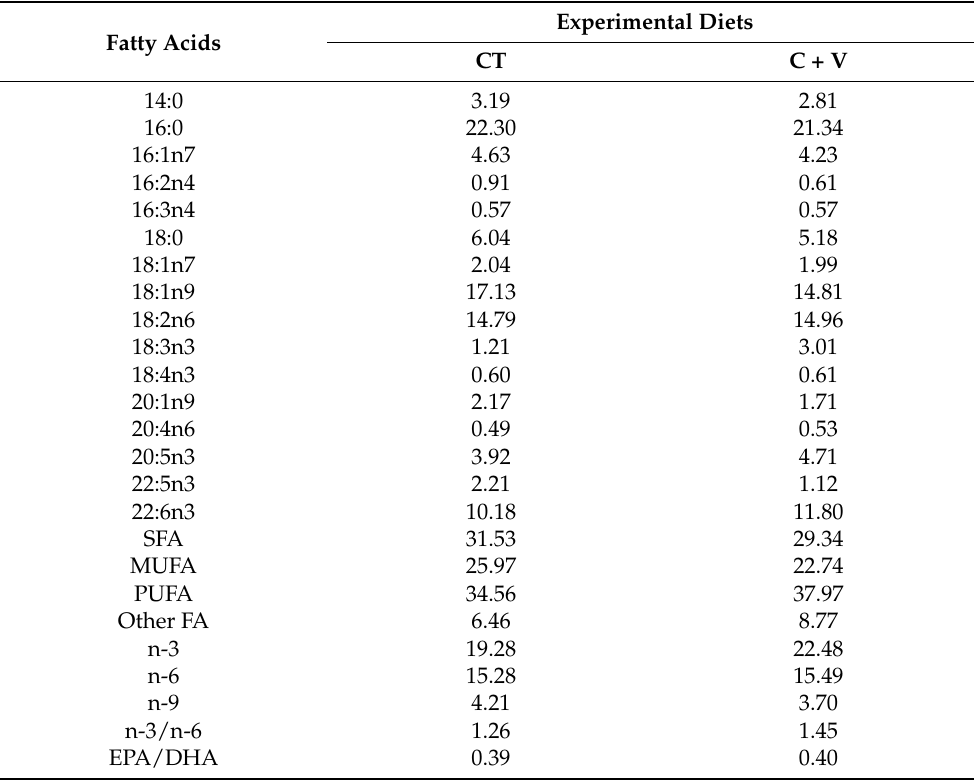
Table 2. Fatty acid composition (% of total fatty acids) of the experimental